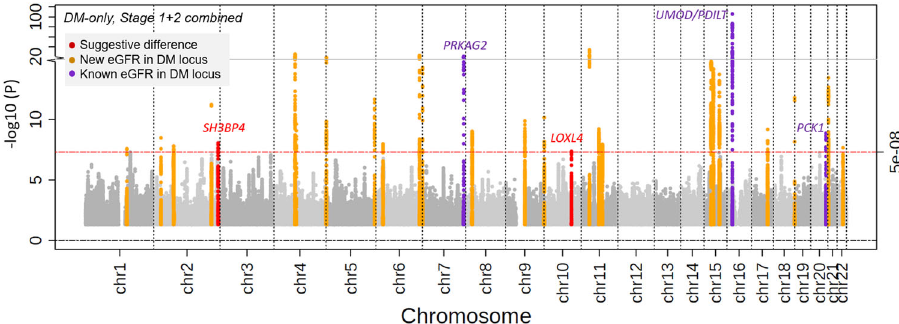
Fig. 5 DM-only eGFR GWAS identi fi ed 29 loci, including 27 novel for eGFR in DM. Shown are eGFR association P -values in individuals with DM over chromosomal position in combined stage ( n DM = 178,691). This DM-speci fi c analysis identi fi ed 29 independent eGFR-associated loci in DM. Compared to known DKD loci 22,23 (i.e., association with eGFR or CKD in type 1 and/or type 2 DM individuals) and known overall eGFR loci 16,20 , 2 loci are novel for eGFR overall and novel for DKD (red), 24 are novel for DKD but known for eGFR (orange), and 3 are known DKD and known eGFR loci (purple).